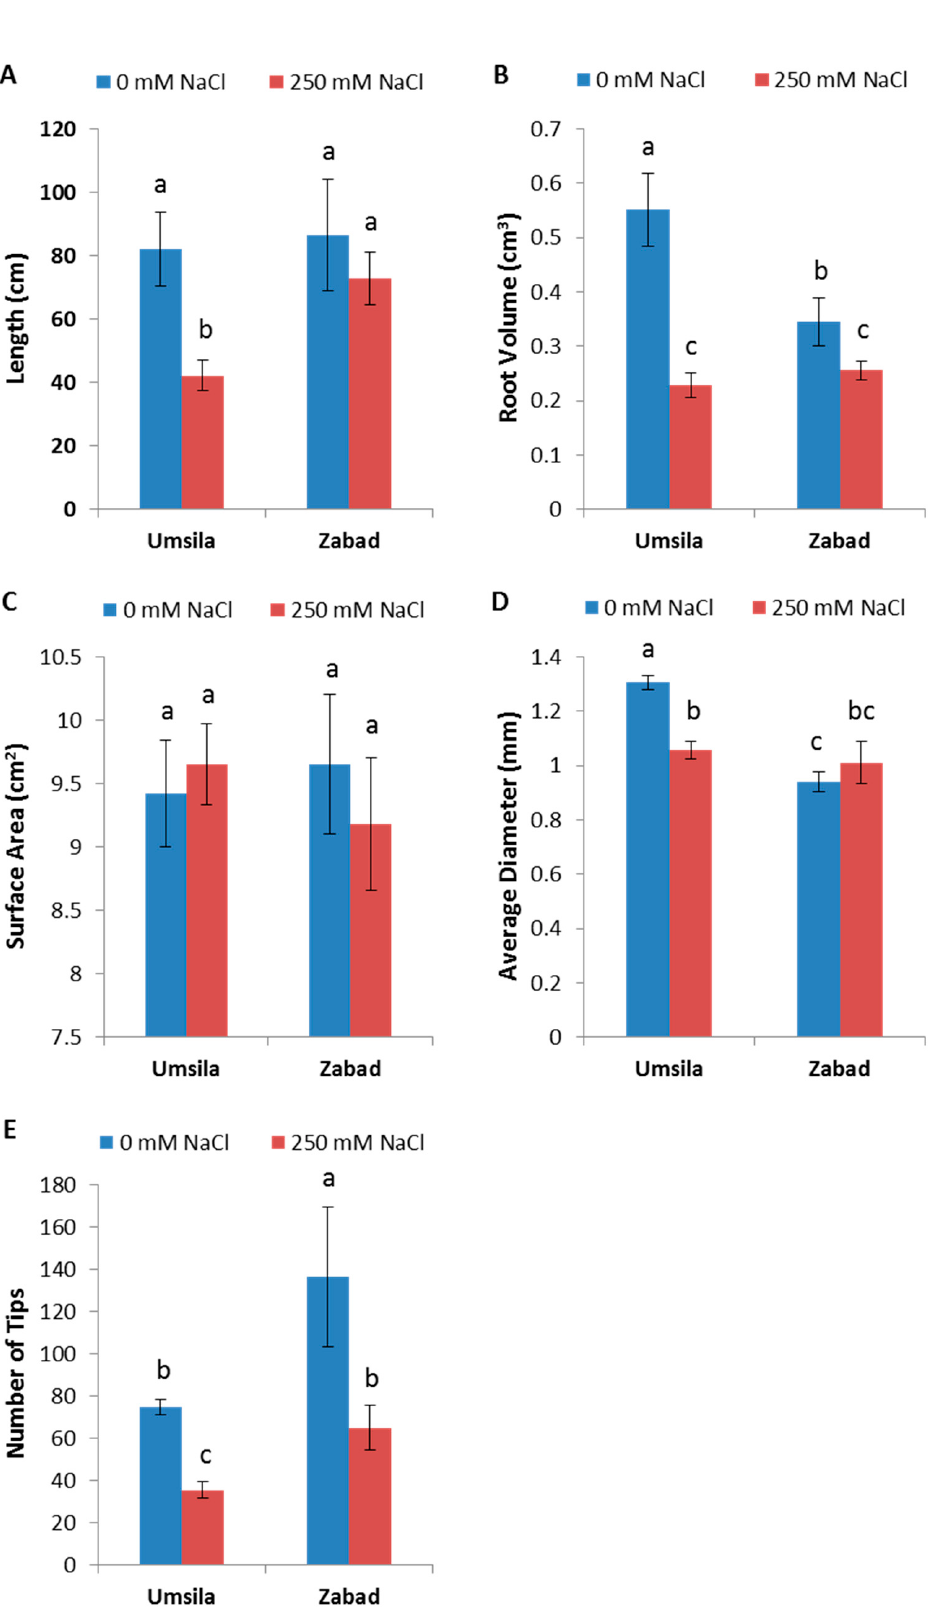
Figure 3. The effect of salinity on the growth of the roots. The root’s ( A ) length, ( B ) volume, ( C ) surface area, ( D ) average diameter, and ( E ) number of tips of cultivars “Umsila” and “Zabad” when exposed to 0 mM and 250 mM NaCl. The bars represent the mean ± SE (n = 4). Significant differences were calculated based on p ≤ 0.05. The bars with the same letter are not significantly different.